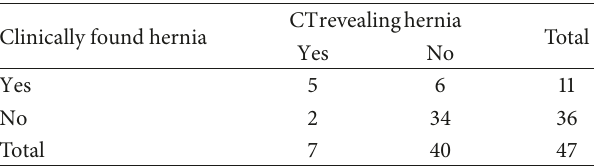
Table 4: Cross-table comparing findings at clinical judgement with findings at CT